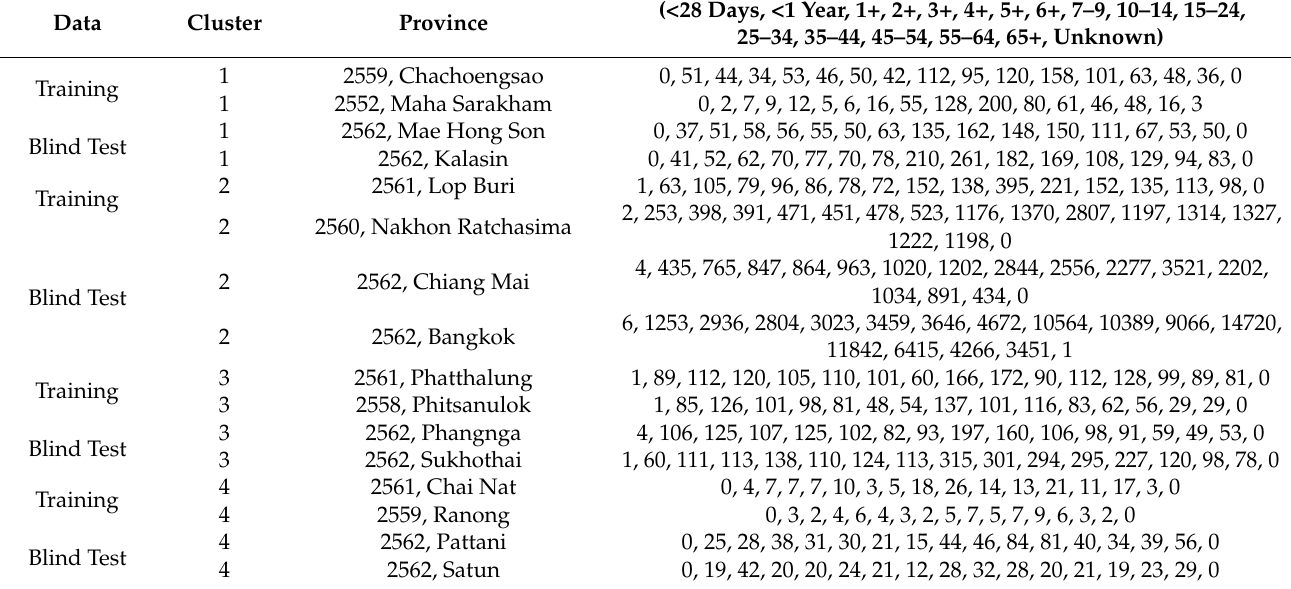
Table 12. The example of clustering results from the selected models for the influenza dataset for the age range category.